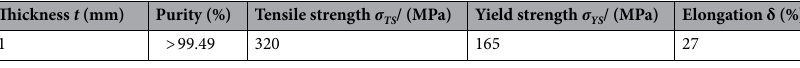
Table 1. Properties of pure titanium.